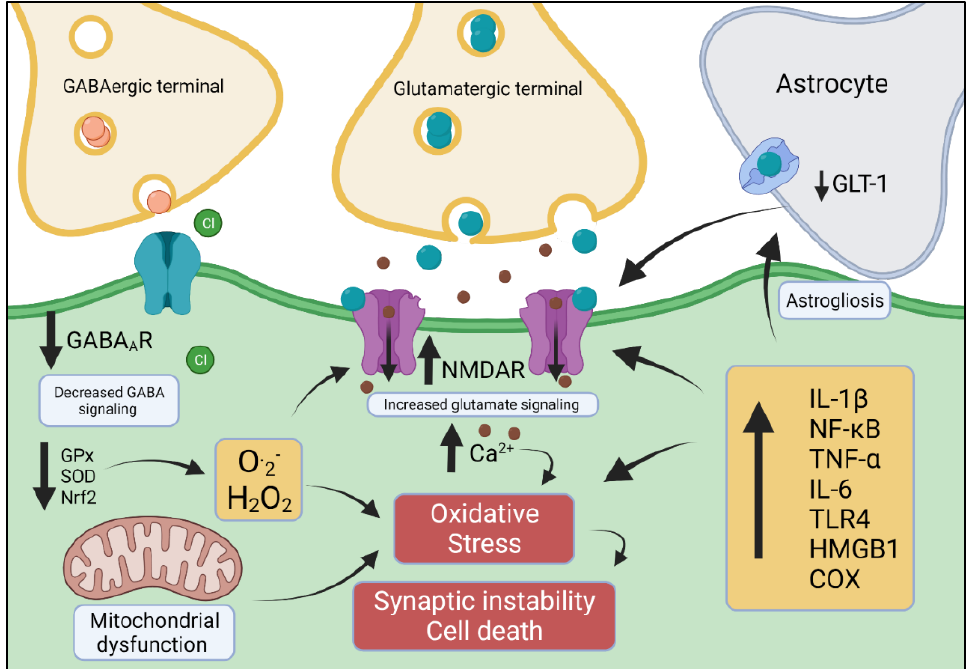
Figure 1. Interconnected mechanisms of epilepsy involving OS. Reduced GABA-mediated inhibitory responses paired with increased glutamatergic tonus (through NMDA currents and/or astrocyte clearance dysfunction) leads to increased intracellular calcium concentration, which is the main source of hyperexcitability as well as OS-associated feedback. In addition, a reduction in the expression of antioxidant defence proteins (for example, GPx, SOD and Nrf2) have been reported in epileptic patients and in animal models of epilepsy. The increased formation of ROS and consequent mitochondrial dysfunction contribute synergistically to OS resulting in synaptic malfunction and cell death. These events are all supplemented by neuroinflammation (e.g., indicated by increase cytokine expression) that potentiates OS and induces astrogliosis, in-turn impacting NMDA function and causing cell death.